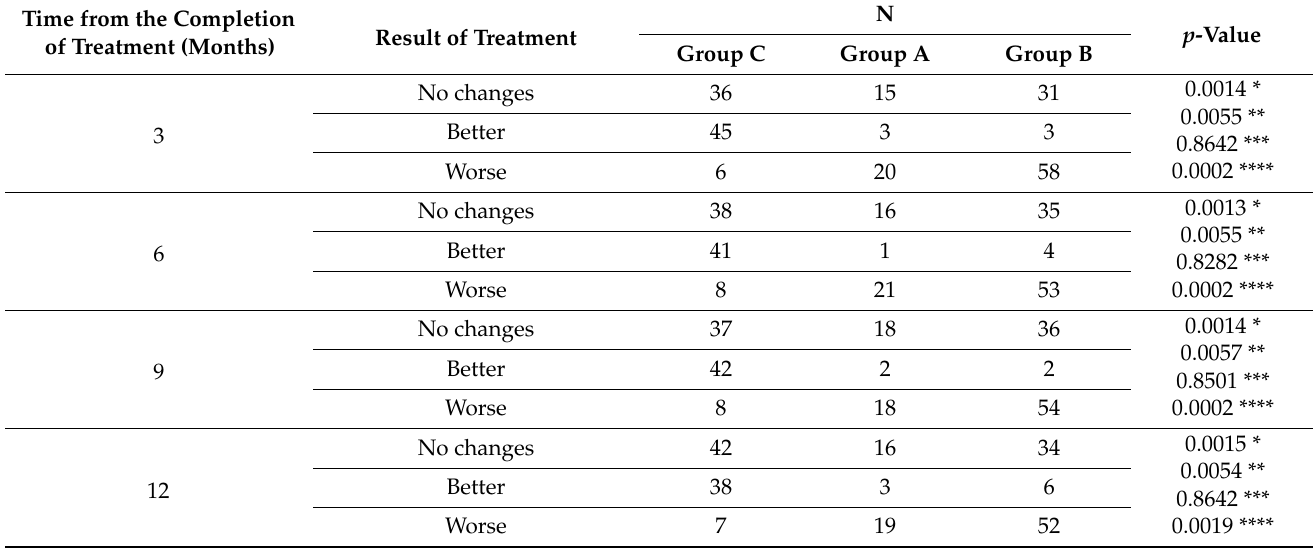
Table 2. Results of the SWLS survey assessing the quality of